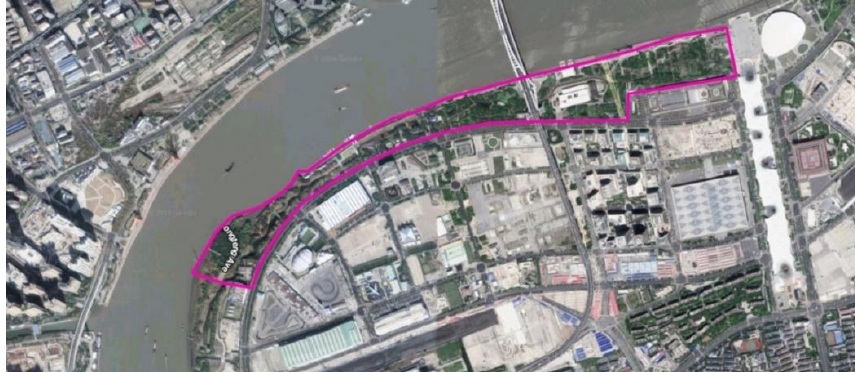
Figure 8. Location of Houtan Park in Shanghai, China, [compiled by A. Nowysz, based on: www.google.pl/maps, (accessed on 16 August 2018)].